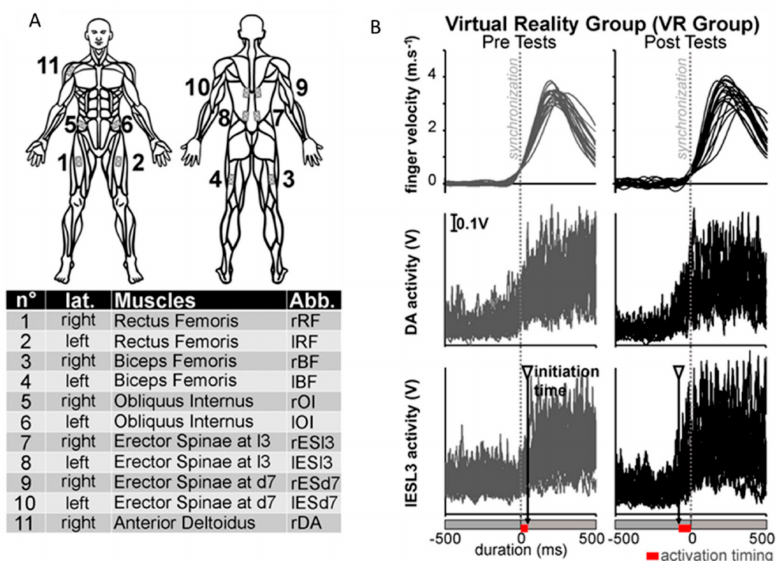
Figure 3. Panel ( A ): The upper part locates and numerates the recorded muscles on the anatomical representation of the human body. The lower part summarizes for each muscle number from left to right: the laterality, the muscle name, and its abbreviation in this article. Panel ( B ): Raw data of a typical participant from the VR rehabilitation training group. In each graph, the 20 recording trials are superimposed. The left column reports the pre-test measures with grey lines whereas the right column reports the post-test measures with black lines. All the recording data were synchronized to the hand movement onset and represented here from 500 ms before the hand movement onset to 500 ms after. In lines, from top to bottom, the finger velocities (m.s − 1 ), the deltoid (anterior portion, DA), and the left erector spinae at the third lumbar vertebra (lESL3) are reported. Kinematics signals are filtered with a dual-pass algorithm with a 30 Hz cut-off frequency (Butterworth 4th order). EMG signals are bandpass filtered between 5 and 400 Hz, full-wave rectified, and then filtered using a no-lag averaging moving-window algorithm with a 10 ms window size. The following overall arm-raising movement analyses and more particularly the detection of initiation time in the EMG activities were carried out using this kind of typical data. For the lESL3 panels, in the pre- and post-tests, the average initiation time is highlighted using a grey triangle and a black vertical arrow. Consequently, along the duration scale, for both the pre- and post-tests, the average activation timing (i.e., the delay between the hand movement onset and the average beginning of the significant lESL3 activation) is highlighted by a red rectangle. (For interpretation of the references to colour in this figure legend, the reader is referred to the web version of this